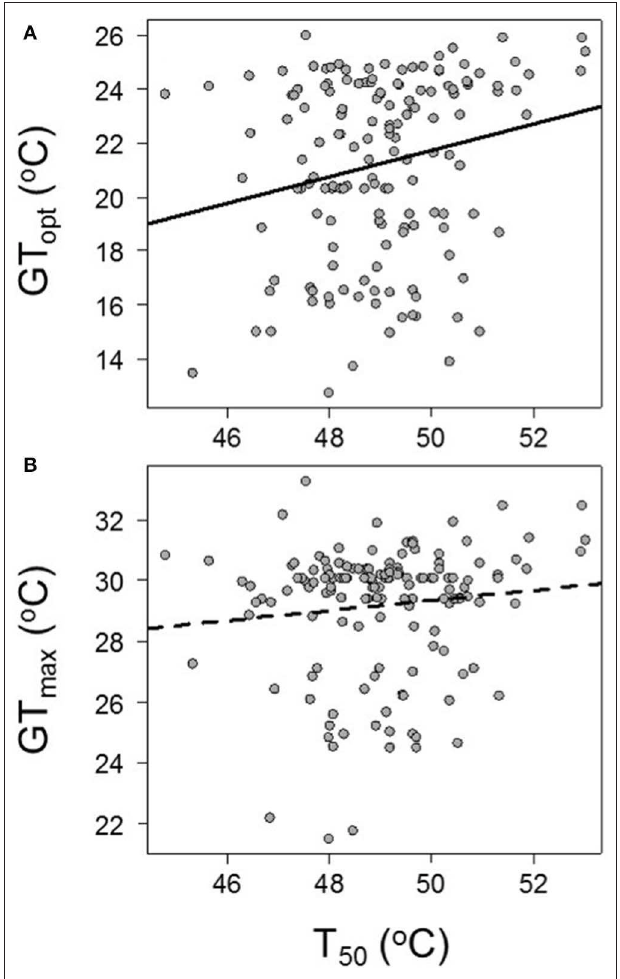
FIGURE 4 | The relationships between species’ physiological maximum thermal tolerance (T 50 ) and (A) GT opt and (B) GT max . GT opt = − 2.93 ◦